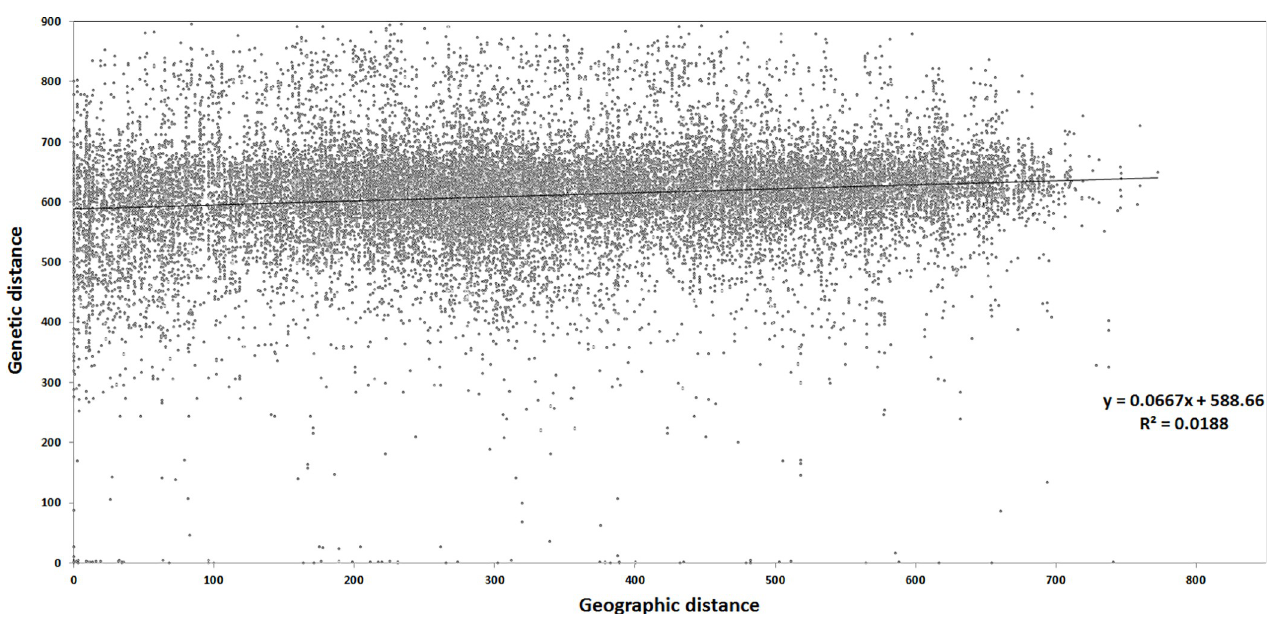
Fig 4. Mantel test for the 239 landraces based on the relationship between the genetic distance and the geographic distance based on GPS data.